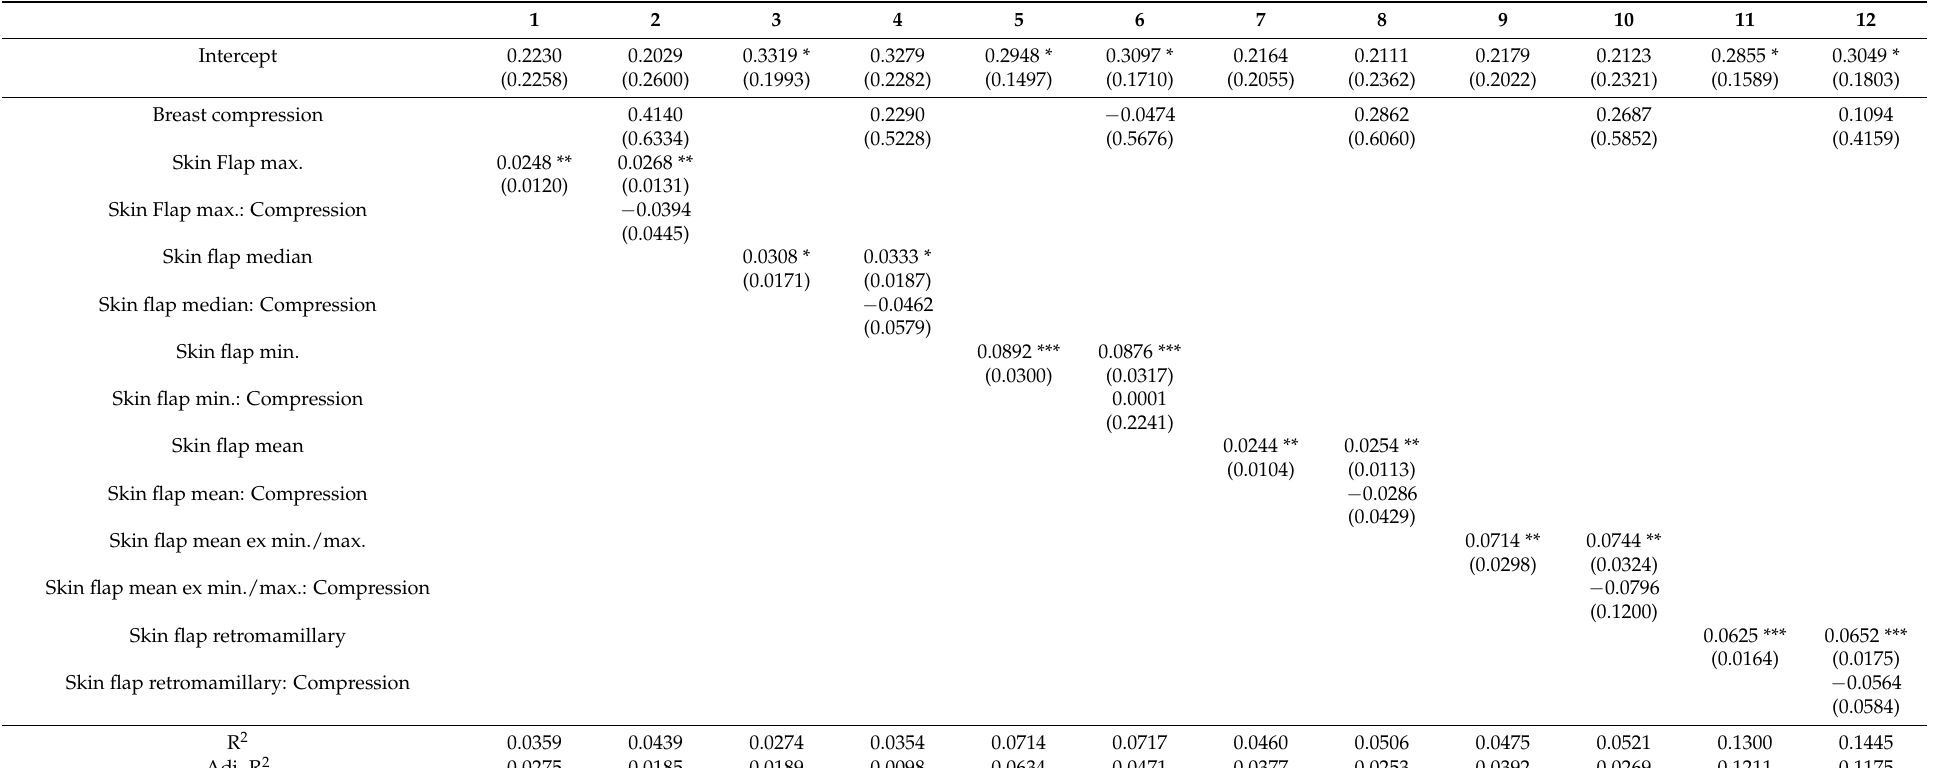
Table 4. OLS regression—residual glandular tissue